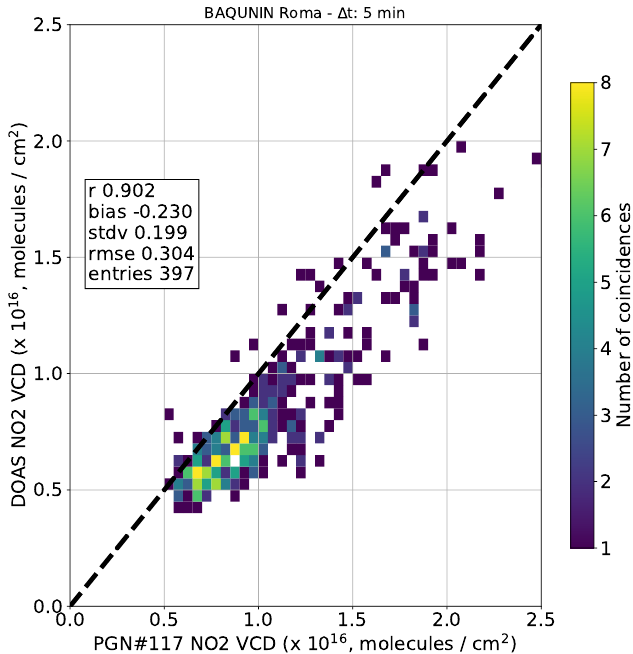
Figure 8. Scatterplot of NO 2 VCDs retrieved from SkySpec-2D (NO 2 cross sections at 254.5 K) and Pandora#117 during the BAQUNIN inter-comparison campaign. Data are averaged in 5 min